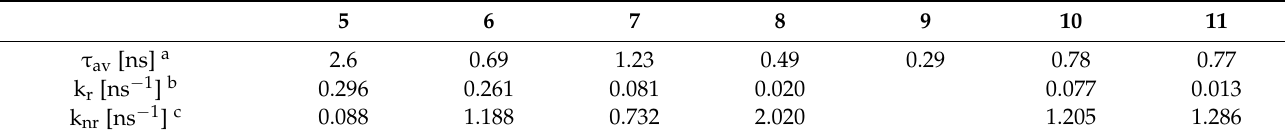
Table 3. Experimental lifetime of compounds 5 – 11 and calculate emission rates for compounds 5 – 8, 10, 11